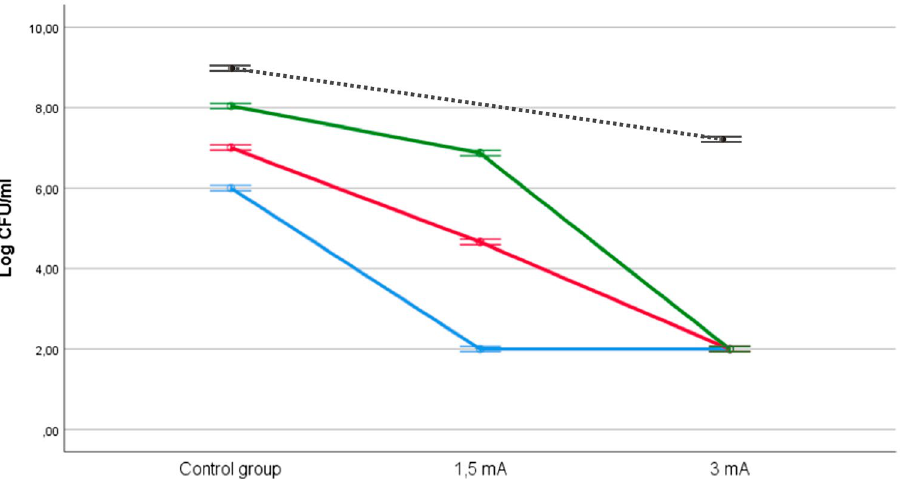
Figure 5. Effect of the application of a different dose of galvanic current in saline solution on three bacterial concentrations: 8 log 10 CFU/mL (green), 7 log 10 CFU/mL (red) and 6 log 10 CFU/mL (blue). Dashed black line represent the reference data for 9 log 10 CFU/mL using the data shown in Fig. 3. The error bars represent the CI (95%).